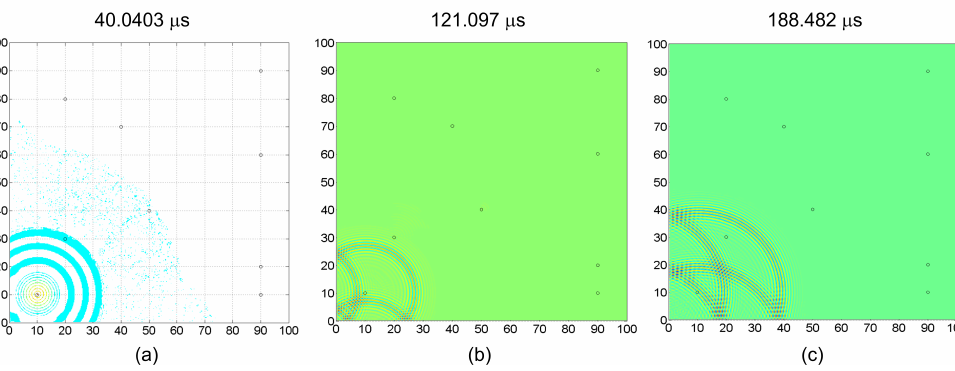
Figure 8. Wave propagation for the numerical model (Actuator-1, Sensor-4).